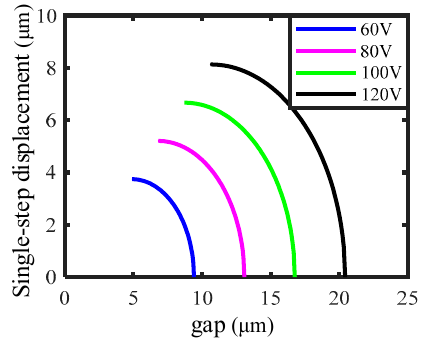
Figure 10. Curves between the single-step displacement of the slider and the gap obtained under different voltages and a constant phase difference of 45°.